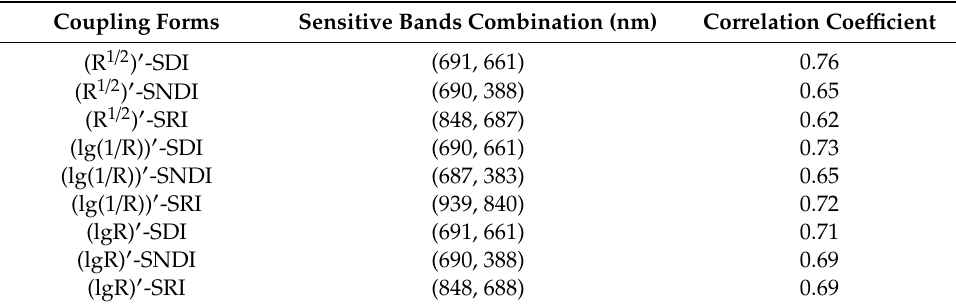
Table 6. Sensitive band combination and correlation coe ffi cients for the combination of spectral transformation and the spectral